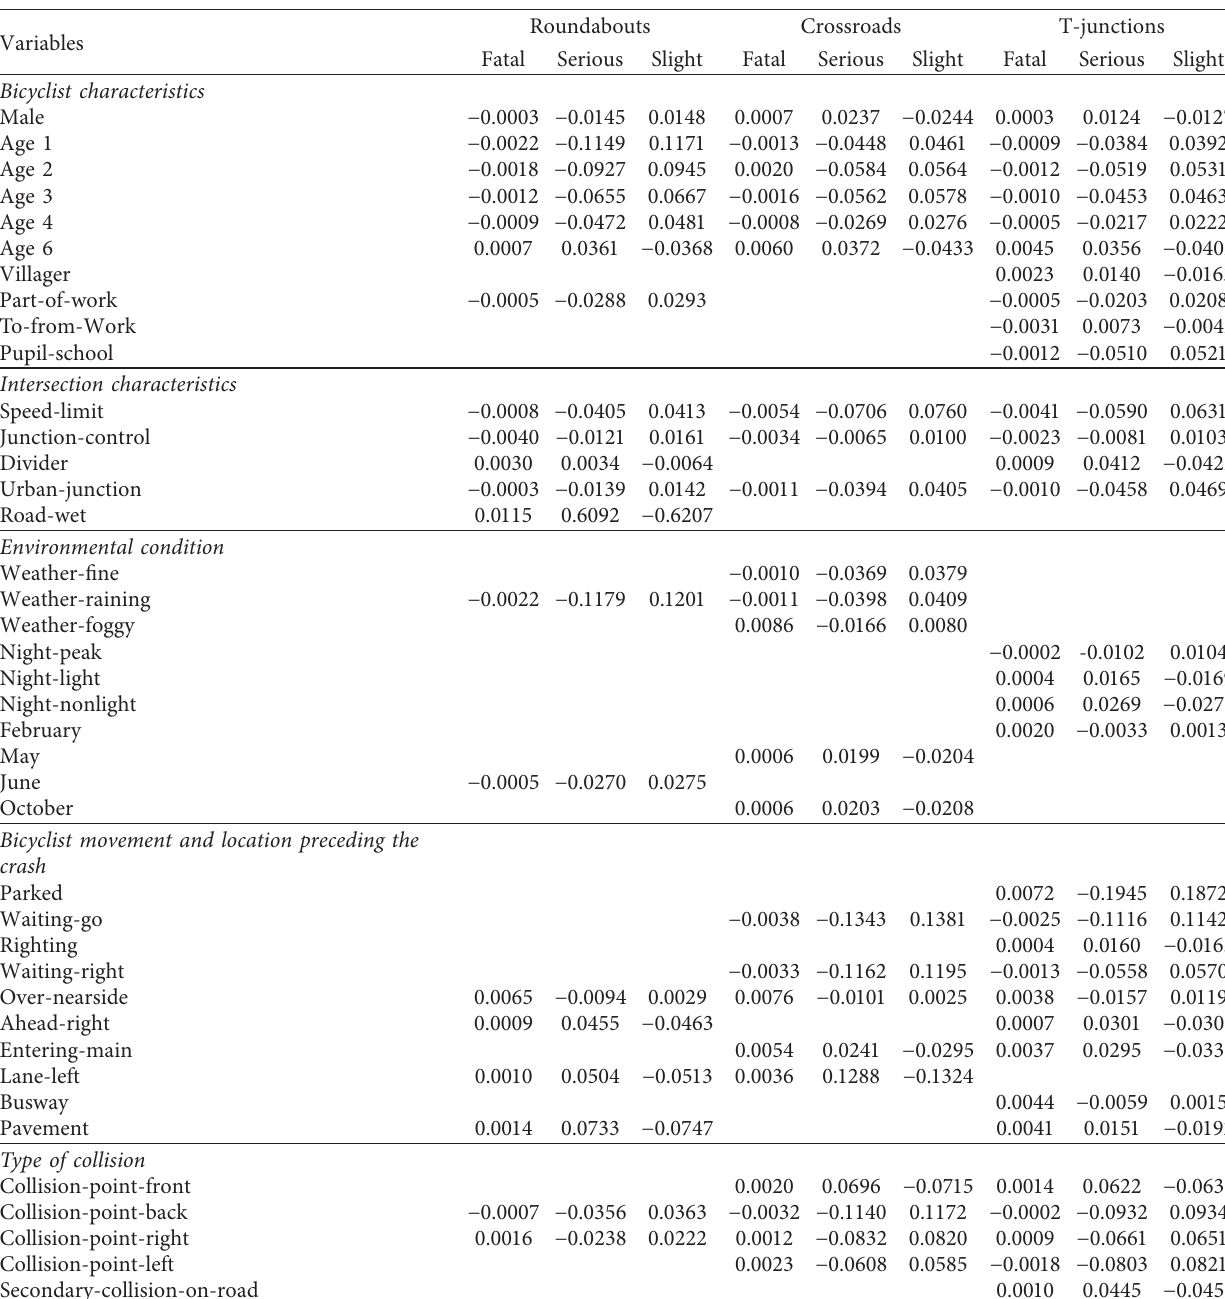
Table 6: Marginal effects for different bicycle crash injury severity levels at different